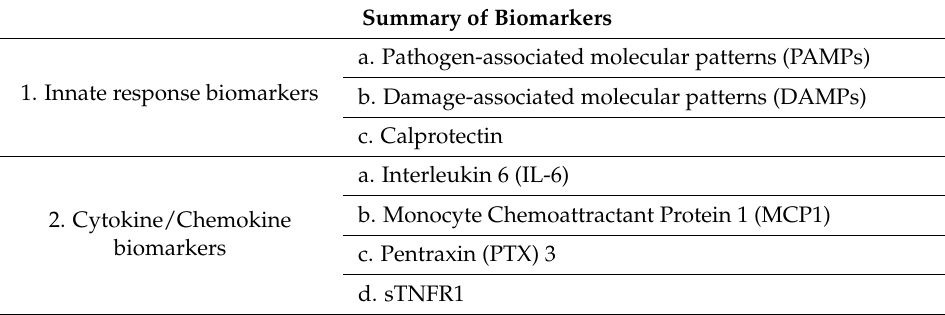
Figure 1. Biomarkers sorted according to their pathophysiological role. Bacterial stimuli cause cell activation and, along with PAMPs and DAMPs, release pro-inflammatory mediators triggering a broad host response. Table 1. Summary of biomarkers for novel therapeutics for sepsis.